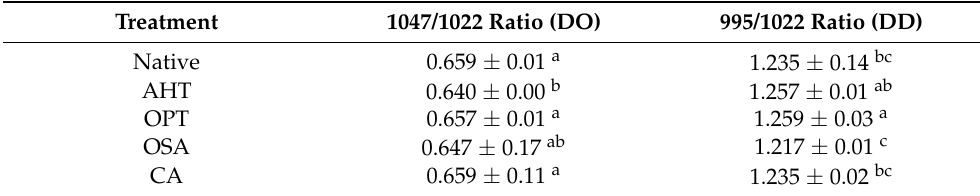
Table 3. The degree of order (DO) and degree of double helix (DD) of native and modified sago starches.